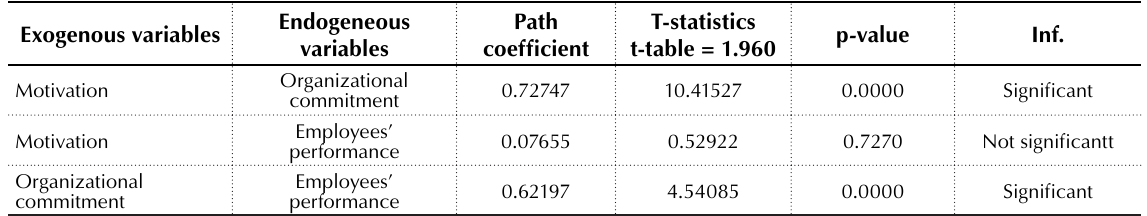
Source: Data processed (2015).